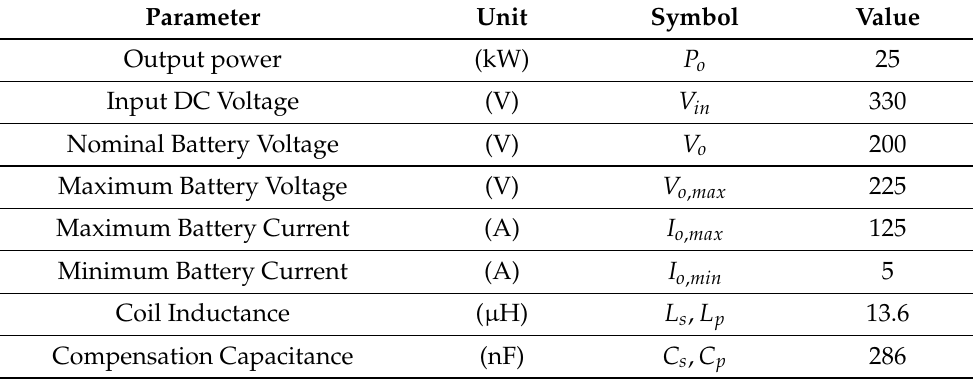
Figure 6. Steady − state voltage and current waveforms for ( a ) boost mode operation ( D = 0.18) and ( b ) buck mode operation ( D = − 0.57). Table 2. Simulation